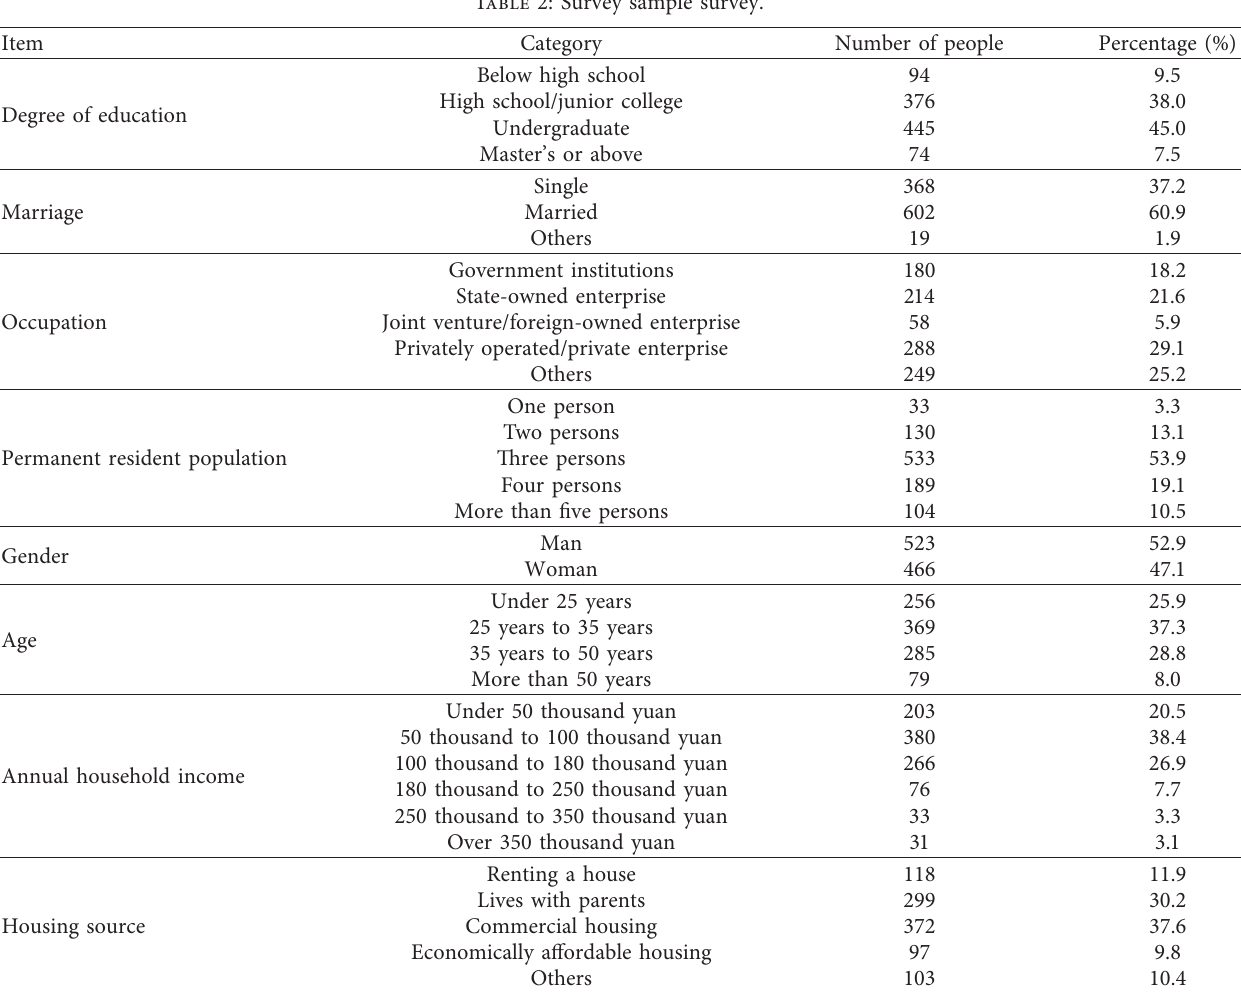
Table 2: Survey sample